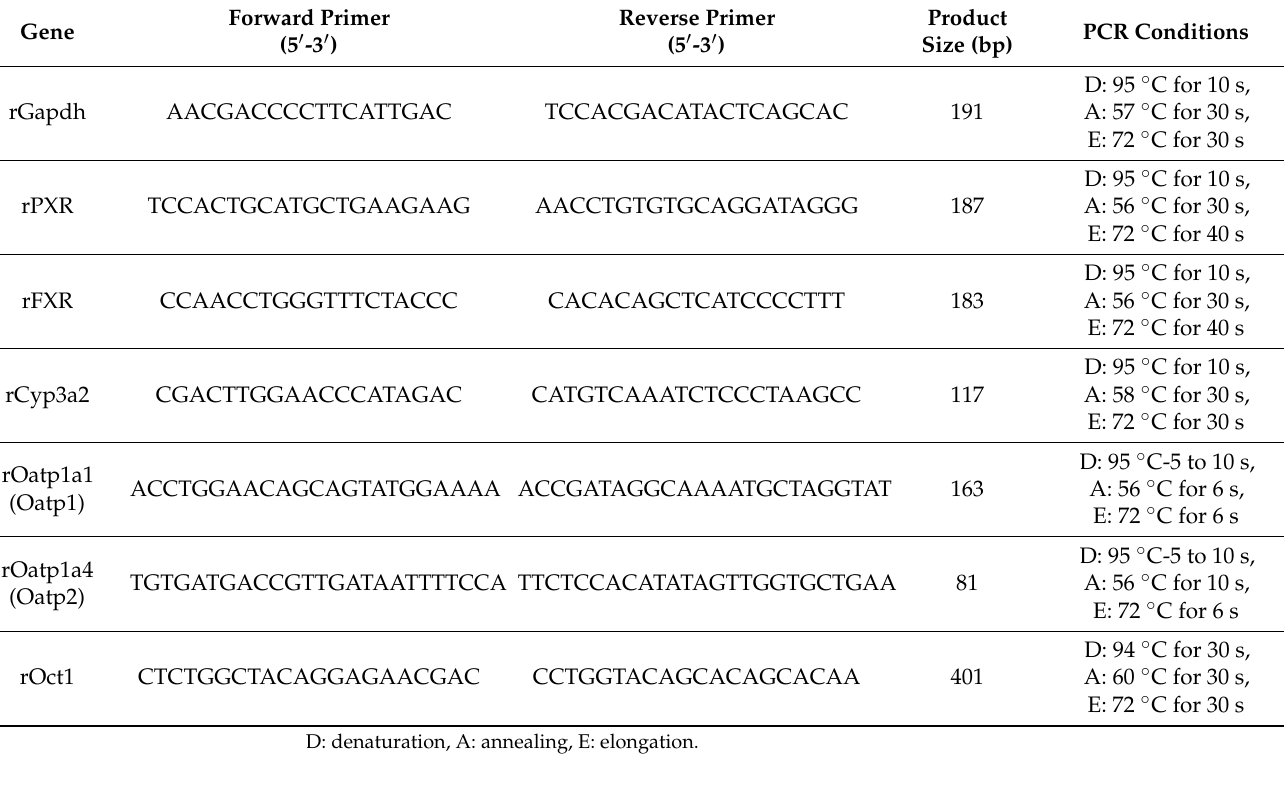
Table A1. Primer sequences and PCR conditions used for the qPCR.